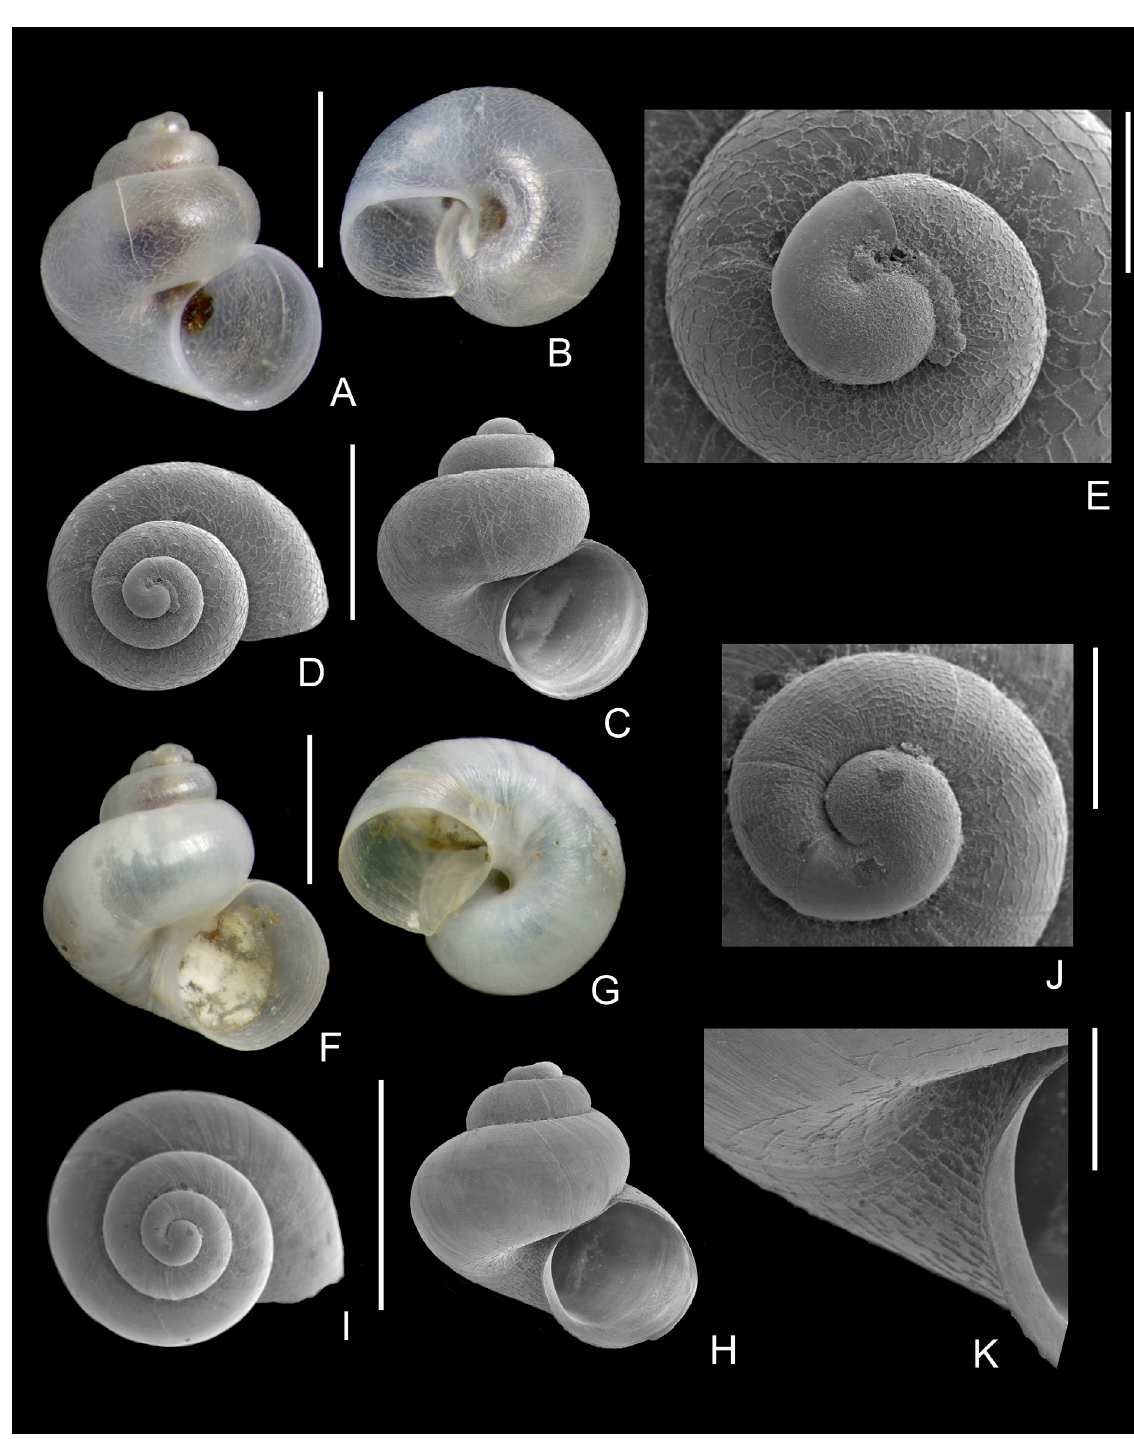
Fig. 16. Skeneimorph species 3. A–B . Anekes affinis (Jeffreys, 1883), BANGAL 0711, V5, 1631 m, diameter 1.4 mm. C–E. SEM micrograph, same specimen, and detail of protoconch and apical whorls, showing the characteristic “ Anekes sculpture”. F–G . Anekes paucistriata Warén, 1992, BANGAL 0711, V5, 1631 m, live taken specimen, diameter 1.9 mm. H–K . SEM micrograph of another shell, detail of protoconch and apical whorls, and detail of the umbilical area. Scale bars: A–D, F–I = 1 mm; E, J–K = 200